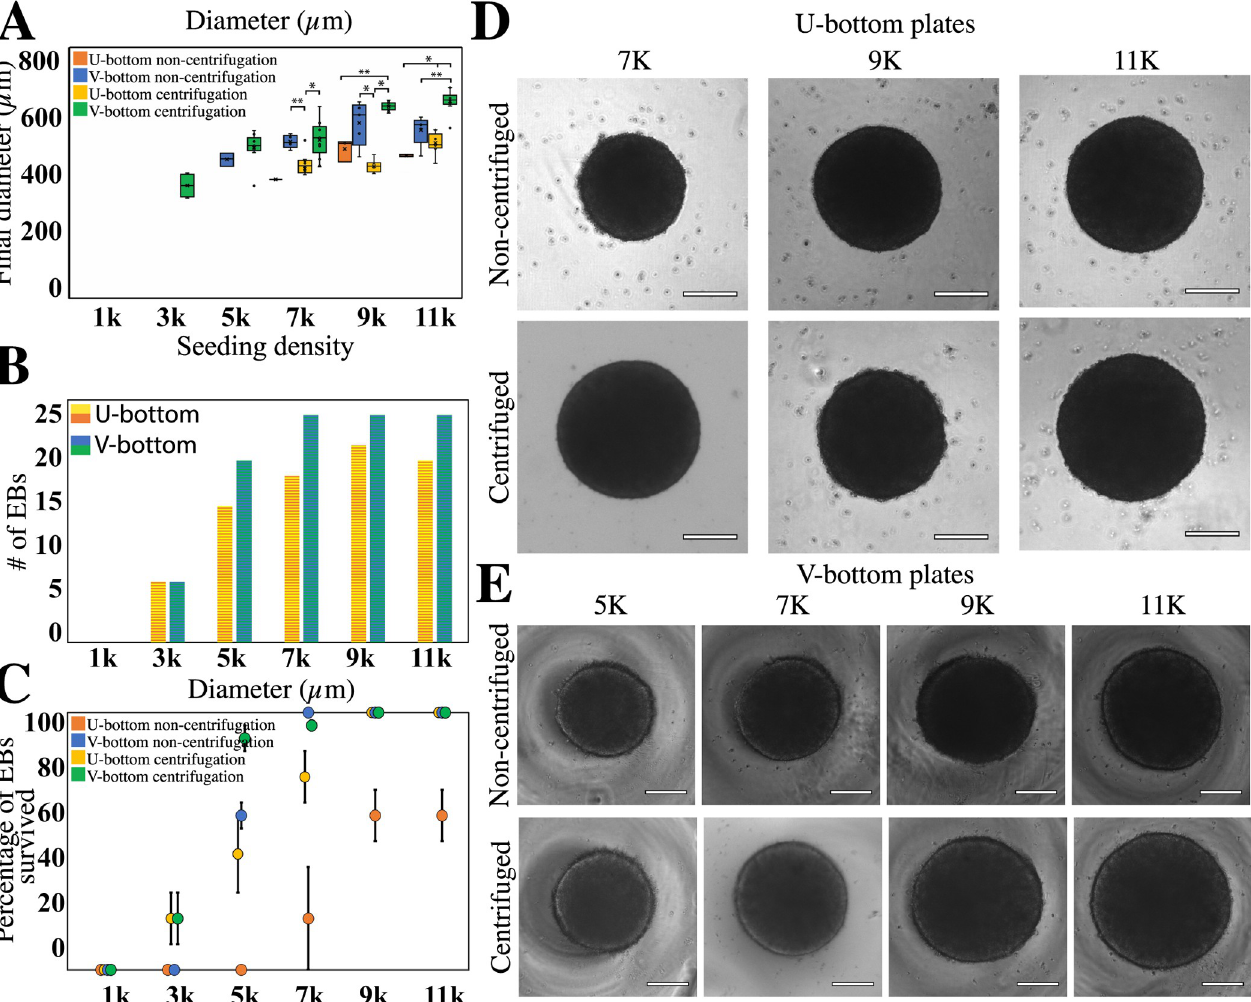
Fig 3. Diameter and survival of EBs fabricated under different conditions. (A) Box-plot distribution of the final diameter of EBs at different concentrations. Boxes are color coded to indicate the type of well plate and centrifugation treatment used. Box plots include the maximum, minimum, and mean values observed. A single asterisk ( � ) indicates a significant difference of P < 0.001. A double asterisk ( �� ) indicates a significant difference of P < 0.05. We evaluated at least 5 EBs (n = 5) for each experimental group at the beginning of the experiment, and we conducted five independent experiments that included all treatments (N = 5). The distributions of the diameters of EBs produced in V-bottom and U-bottom wells. Average diameters were determined based on the number of EBs (n) that survived the entire culture time. (B) Histogram of EBs produced in U-bottom and V-bottom wells that survived until the end of the experiment. EBs formed in U-bottom wells are shown in blue; EBs formed in V-bottom wells are in orange. The initial number of EBs seeded = 25 in all experiments. (C) Percentages of the numbers of EBs that survived under the different fabrication conditions. (D,E) Brightfield images of spheroids formed at different fabrication conditions after 6 days of